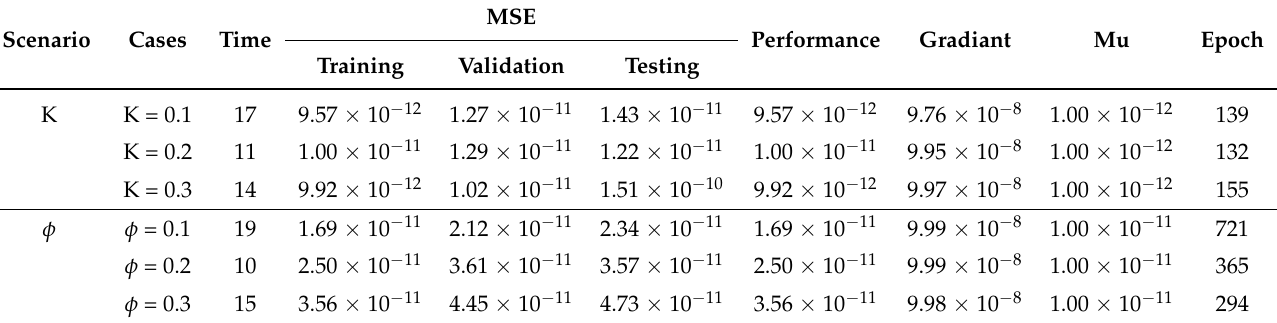
Table 2. Numerical results of ANN of different cases of the rotation parameter K and the volume fraction φ showing the time taken, training, validation, testing, mean square error, gradient, and epoch to reach the best